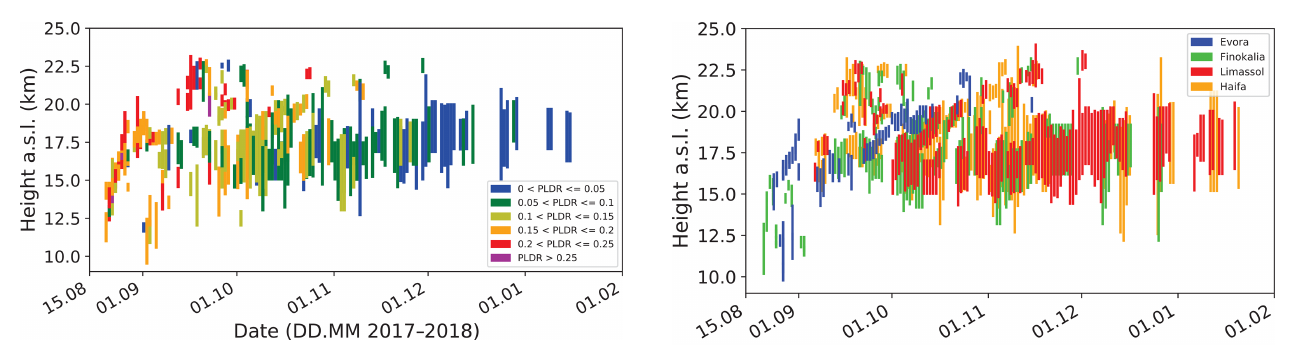
Figure 8. Same as Fig. 4a, except only for the southern Polly sta- tions. The Finokalia data set is shown here in green for better iden- tification. The different data sets are shifted against each other by 6h and the line width is reduced to better see all observations. An ascending structure, first seen over Évora in September (in blue) and then also detected over the eastern Mediterranean in October and November (in green, red, and orange) triggered the discussion about potential aerosol lifting processes and